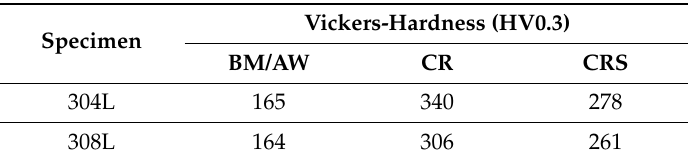
Table 3. Average Vickers-Hardness of the various specimens.